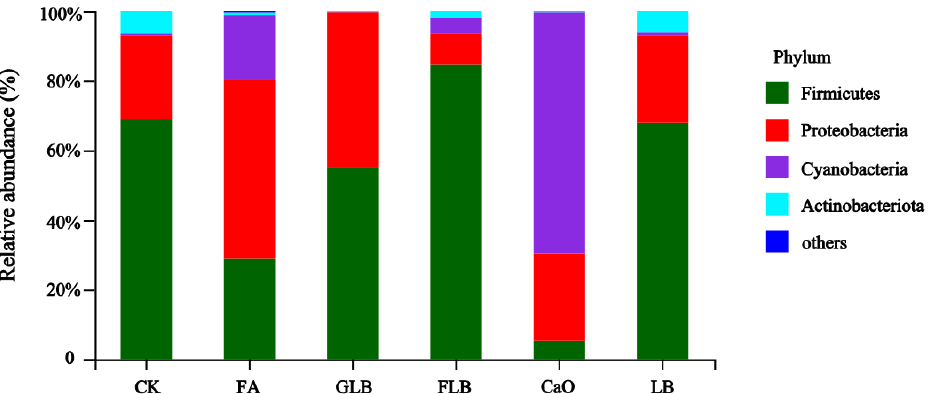
Figure 3. Bacterial communities and relative abundances at the phylum level in alfalfa silage after 60 days of fermentation. CK, control, no additive; FA, 0.6% formic acid; CaO, 3% calcium oxide and 3% urea; LB, 1 × 10 6 cfu/g L. buchneri ; GLB, 2% glucose and 1 × 10 6 cfu/g L. buchneri ; FLB, 2% fucoidan and 1 × 10 6 cfu/g L. buchneri .